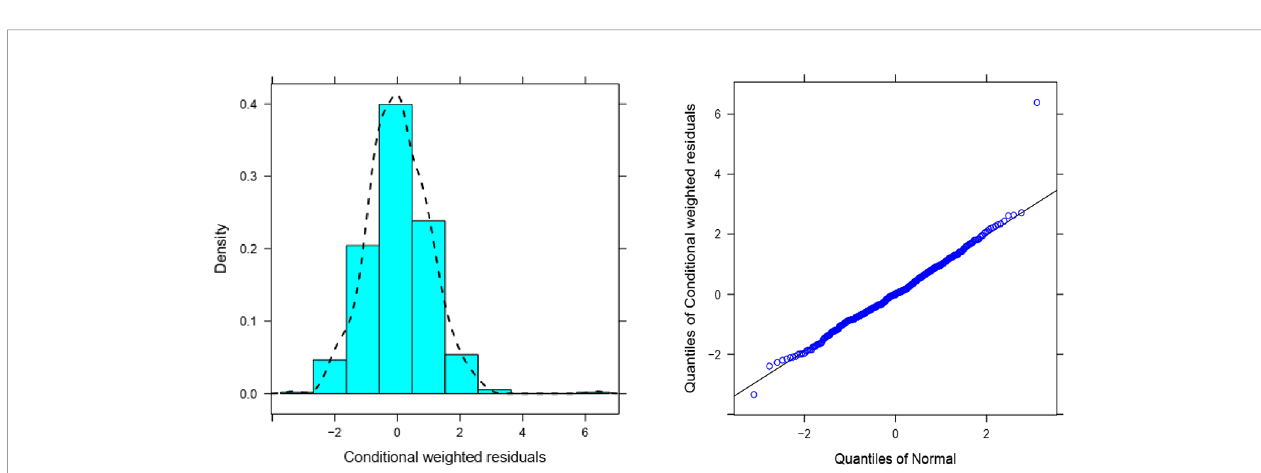
FIGURE 2 | The distribution (histogram (left) and QQ plots (right) of CWRES.